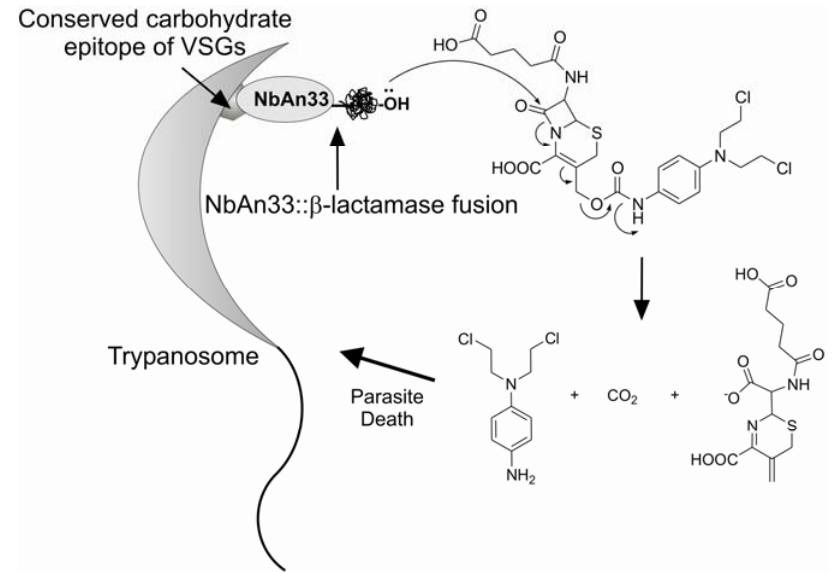
Figure 5. ADEPT approach for African